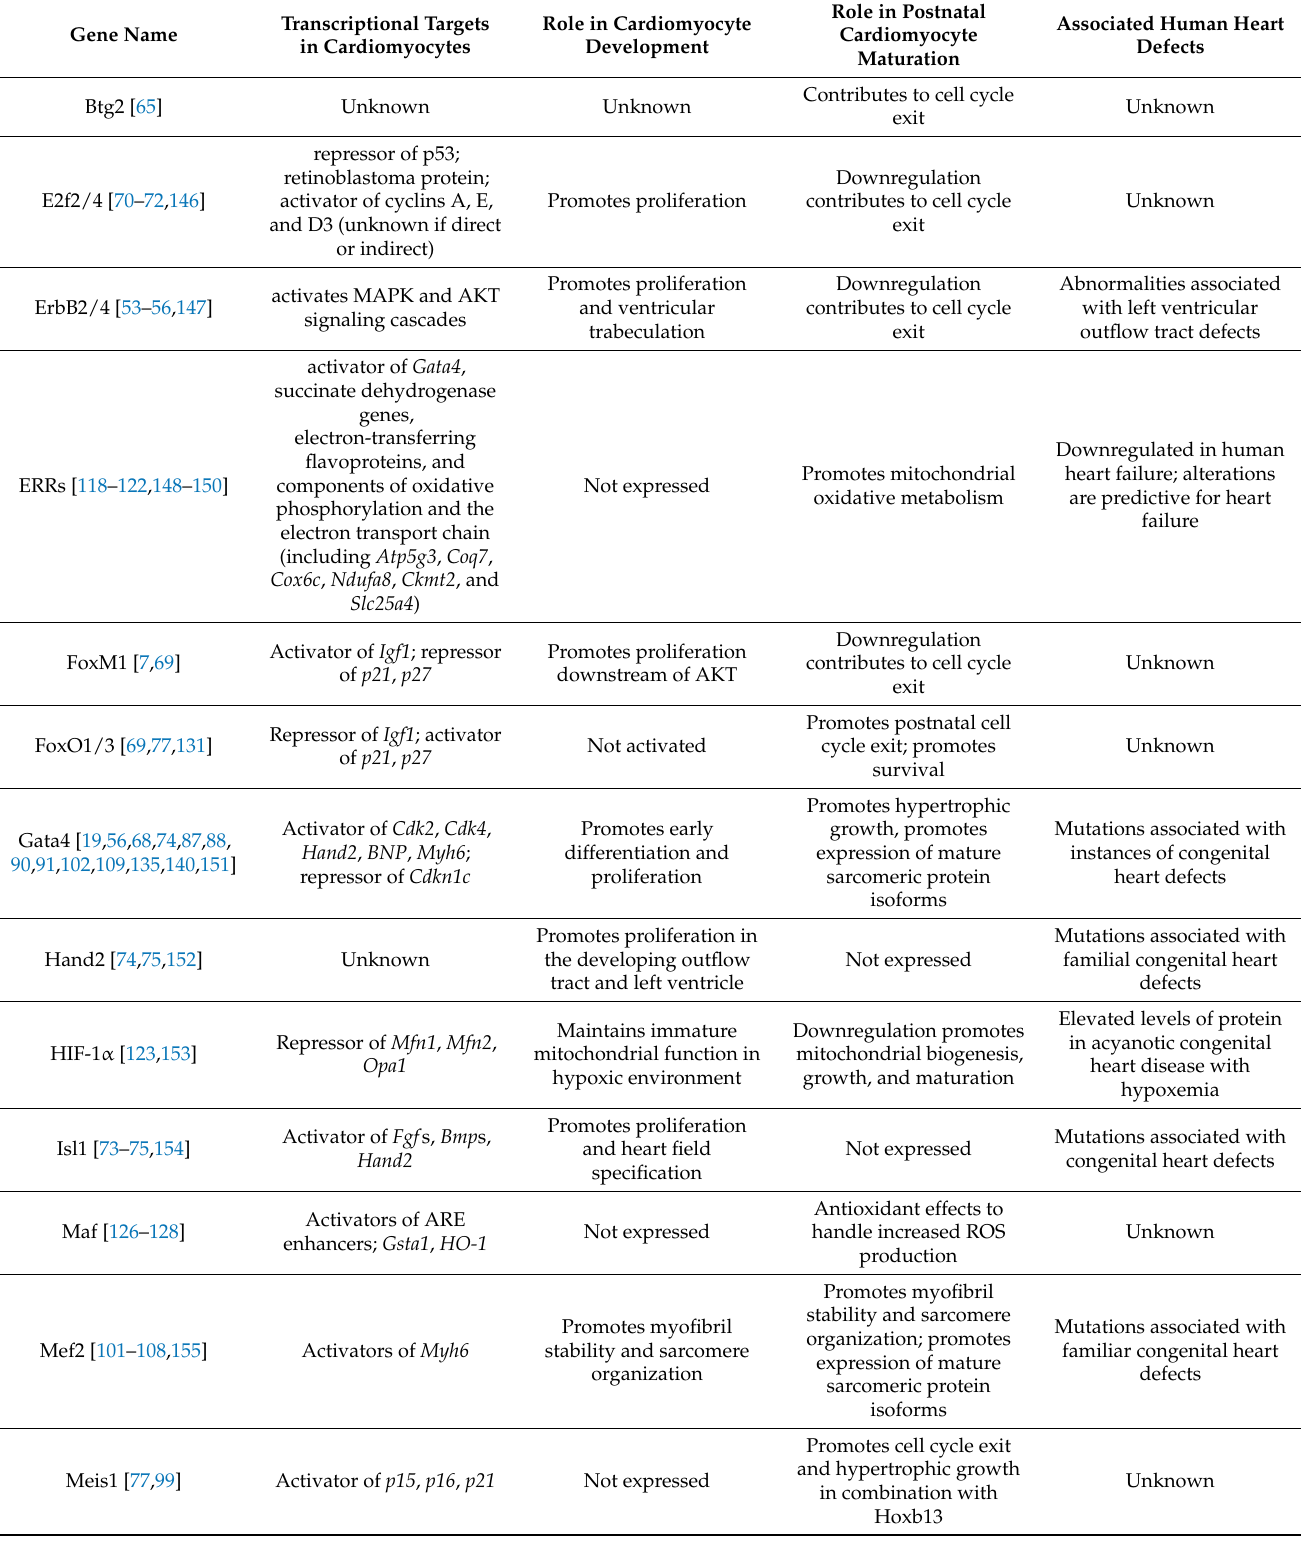
Table 1. Transcriptional regulators of postnatal cardiomyocyte maturation, their targets, roles in embryonic and postna- tal/adult cardiomyocyte function, and human heart defects associated with mutations/abnormalities in these